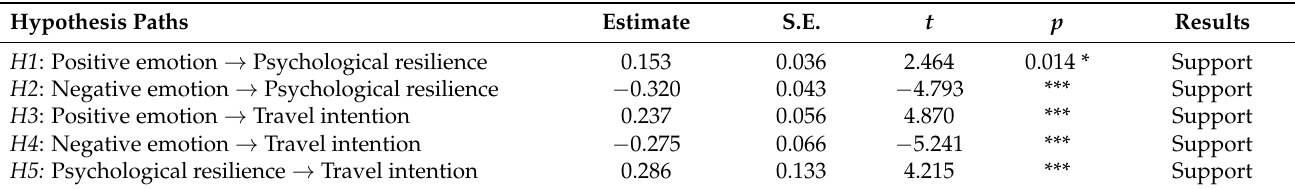
Table 4. Standardization path coefficient and hypothesis testing